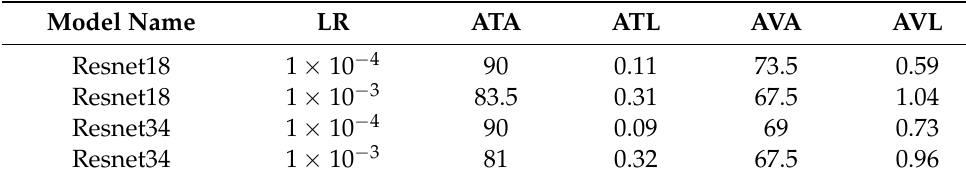
Table 7. Audio classifier results by learning rate